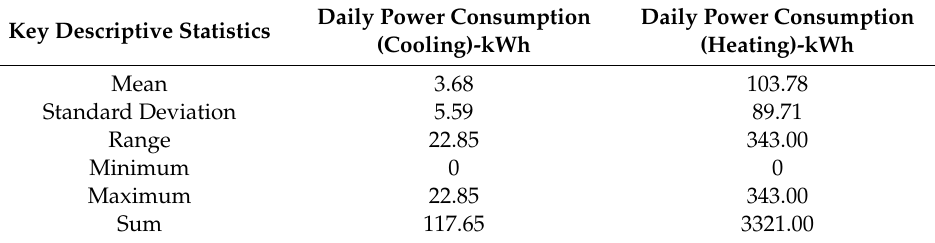
Table A5. Descriptive measures of power consumption during the three plant developing stages.